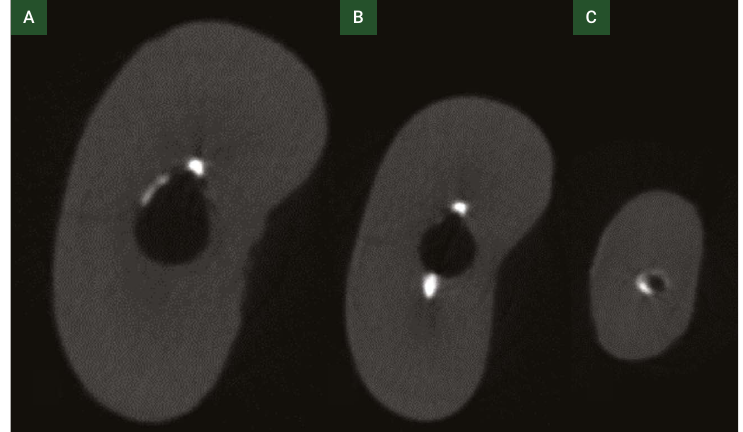
Figure 1. Sections of a RT specimen before removal of the filling material: cervical (A), middle (B) and apical (C) thirds.